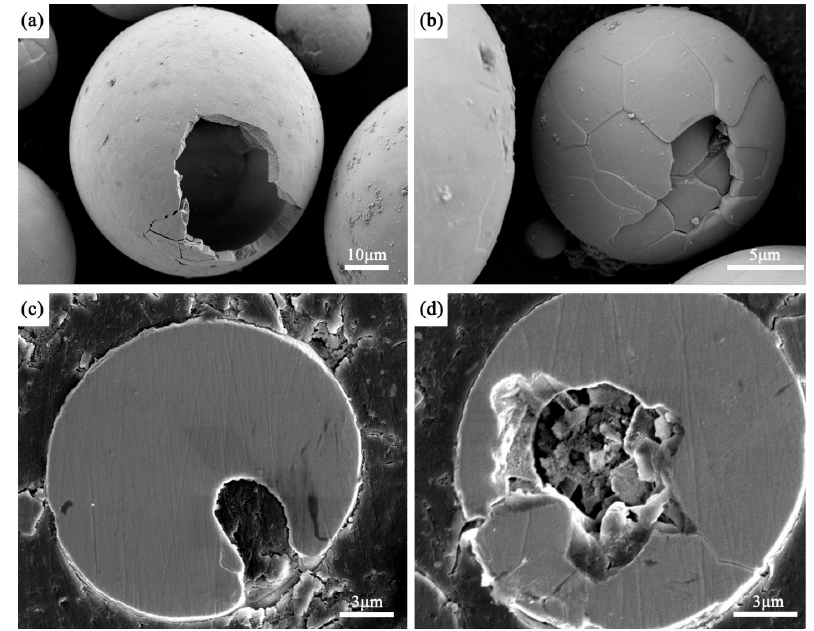
Figure 9. XRD patterns of ( a ) the O-AS powders and ( b ) C-AS particles.